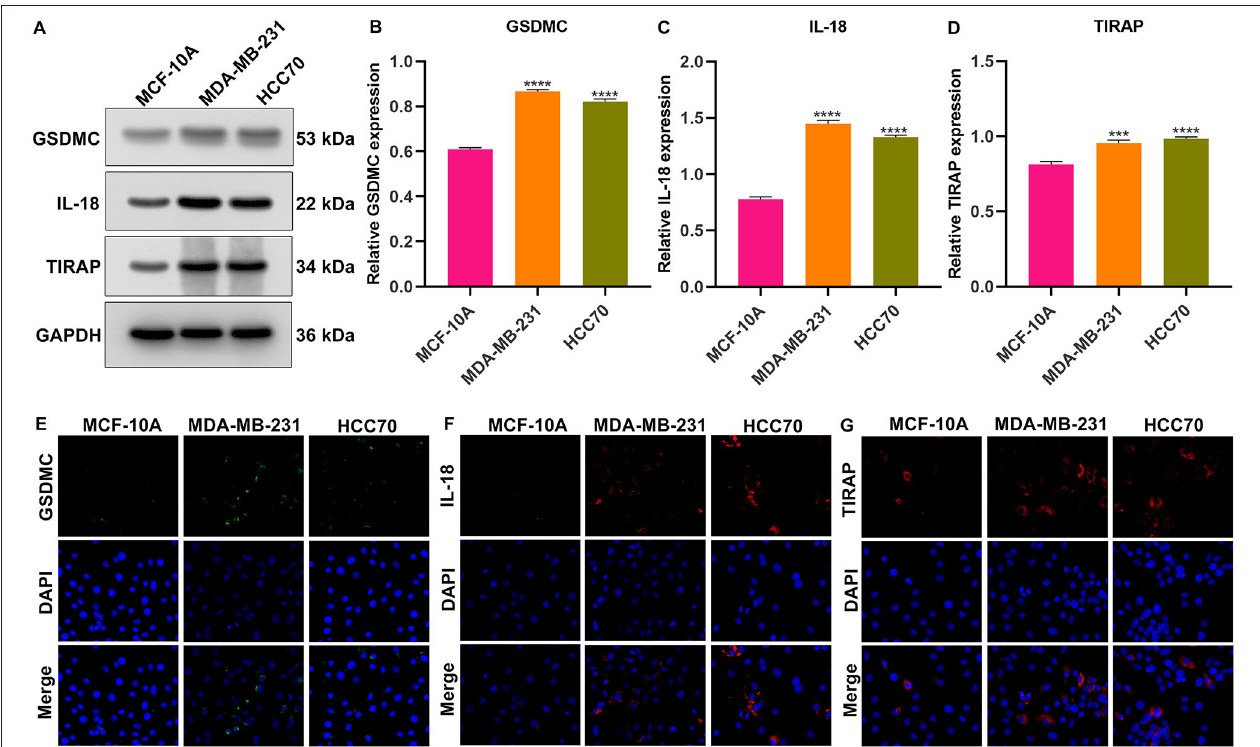
FIGURE 9 | Validation of the expression of GSDMC, IL-18 , and TIRAP in normal breast cells (MCF-10A) and breast cancer cells (MDA-MB-231 and HCC70). (A–D) Western blot detecting the expression of GSDMC, IL-18, and TIRAP in MCF-10A, MDA-MB-231, and HCC70 cells. *** p < 0.001; **** p < 0.0001. (E–G) Immunofluorescence of the expression of GSDMC, IL-18, and TIRAP in MCF-10A, MDA-MB-231, and HCC70 cells. Scale bar, 5 µ m; magnification 200 ×